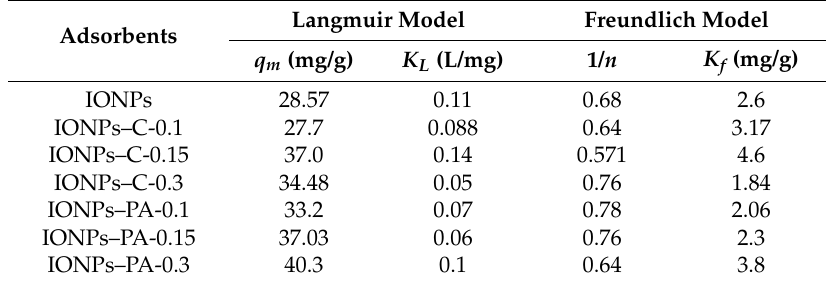
Table 2. Langmuir and Freundlich isotherms parameters for As(V) adsorption on different